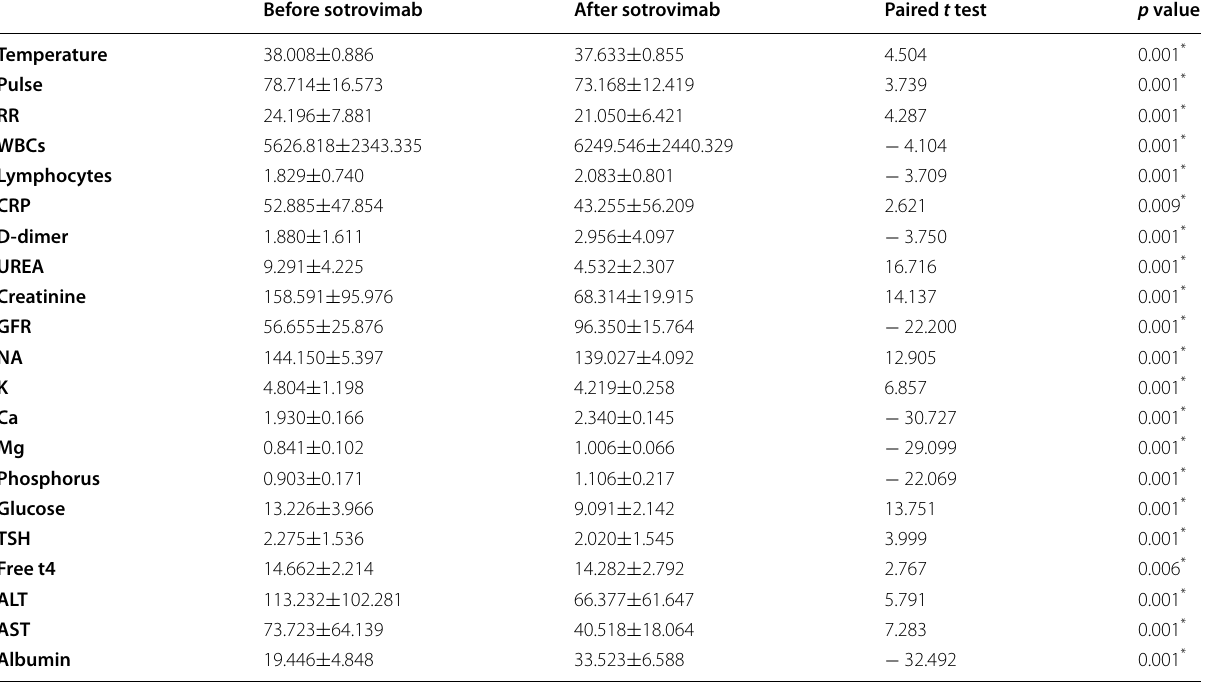
SD standard deviation * Significant